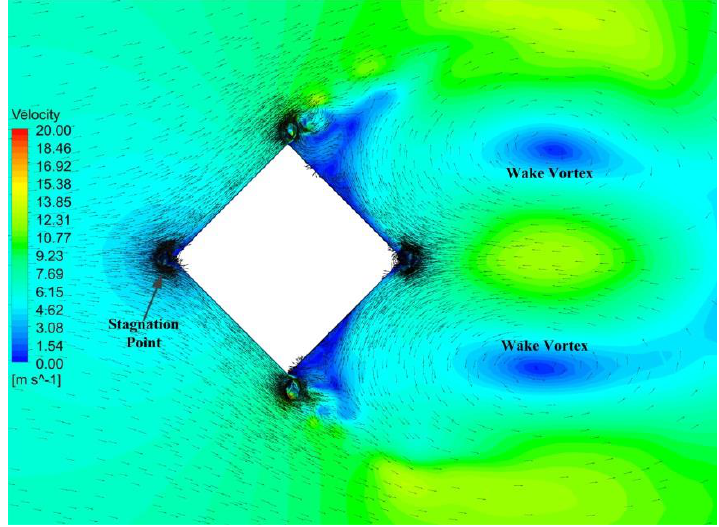
Figure 19. Velocity contours and vectors around the building at φ = 0° and TSR = 0.4.